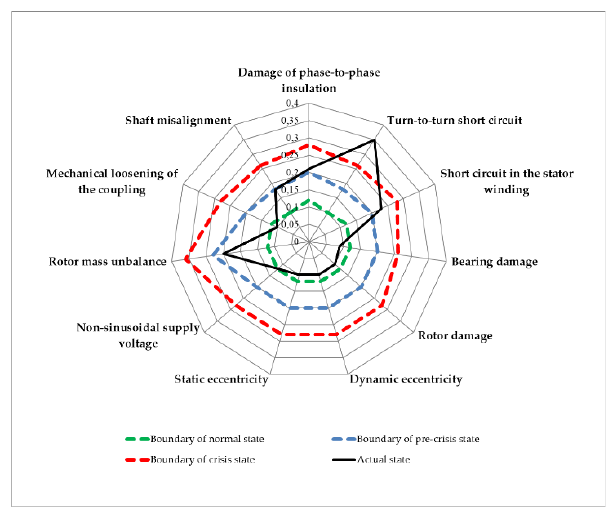
Figure 8. Graph for probabilistic crisis state of the